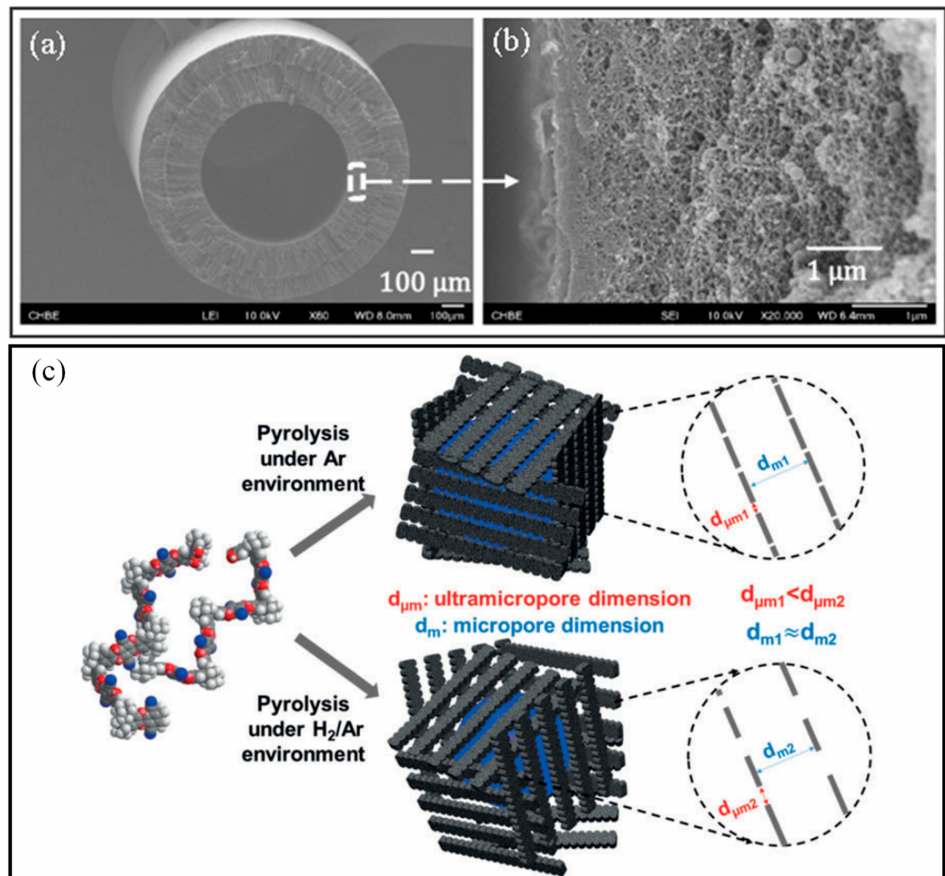
Figure 11. FESEM images of the ( a ) cross-section and ( b ) inner edge morphology of hollow fiber RO membranes with the highest flux. Reprinted/adapted with permission from Ref. [288]. Copyright 2021, Elsevier. ( c ) Illustration demonstrating the introduction of H 2 to the pyrolysis environment lead- ing to an enlargement of the ultramicropores with only minor changes in the size of the micropores. Reprinted/adapted with permission from Ref. [149]. Copyright 2019,